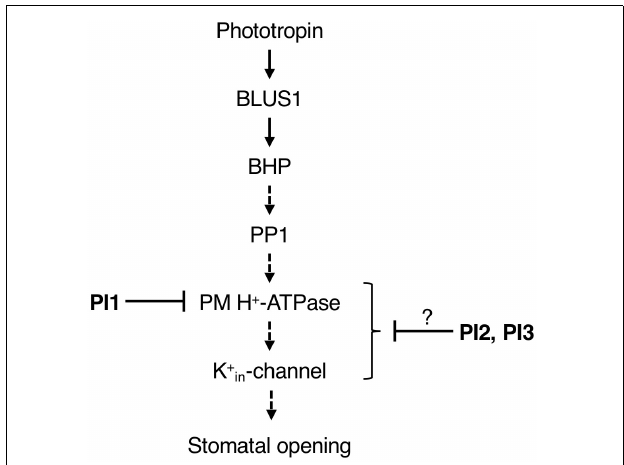
FIGURE 6 | Proposed model of the inhibitory effects of PI1, PI2, and PI3 on the signaling pathway of BL-dependent stomatal opening. The pathway starts from phototropin, followed by BLUS1, BHP, PP1, a key enzyme PM H + -ATPase and K + in -channel. PI1, PI2, and PI3 inhibited BL-induced phosphorylation of PM H + -ATPase. Arrows indicate positive regulation. Blunt arrows indicate